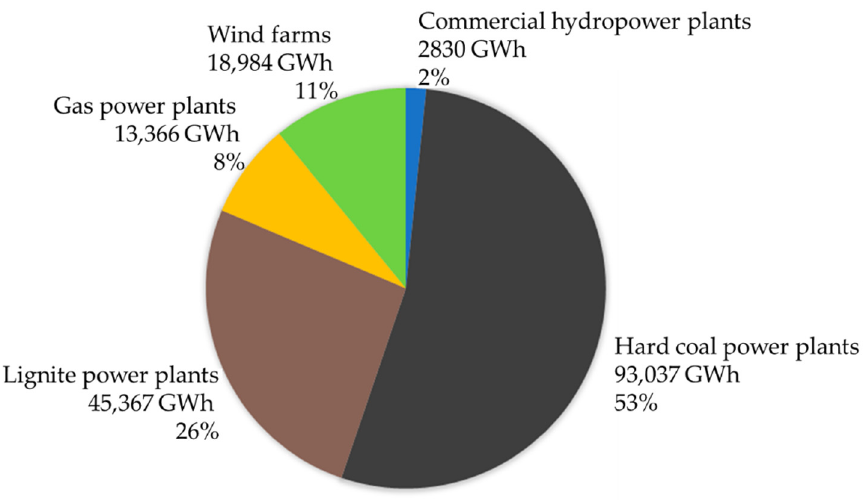
Figure 3. Sources for electricity generation in 2021, in Poland.